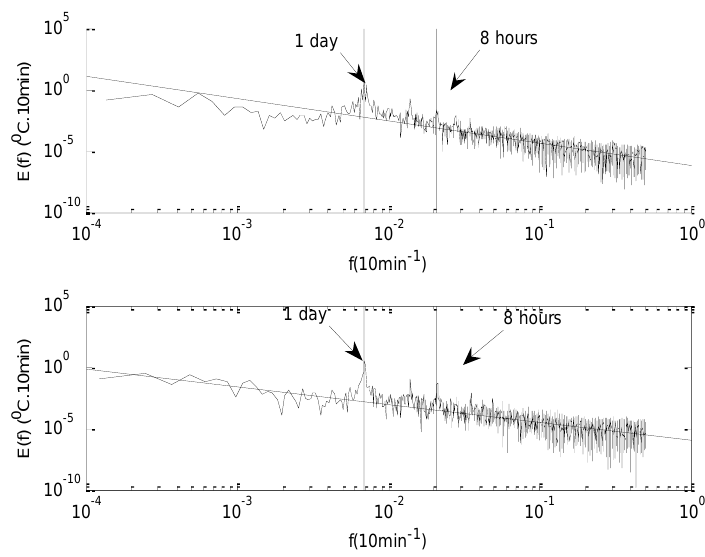
Figure 3. Power spectrum of the temperature time series, in log-log plot, estimated using extended discrete Fourier transform (EDFT). The top panel shows the spectrum for the time series A, the lower panel for the time series B.